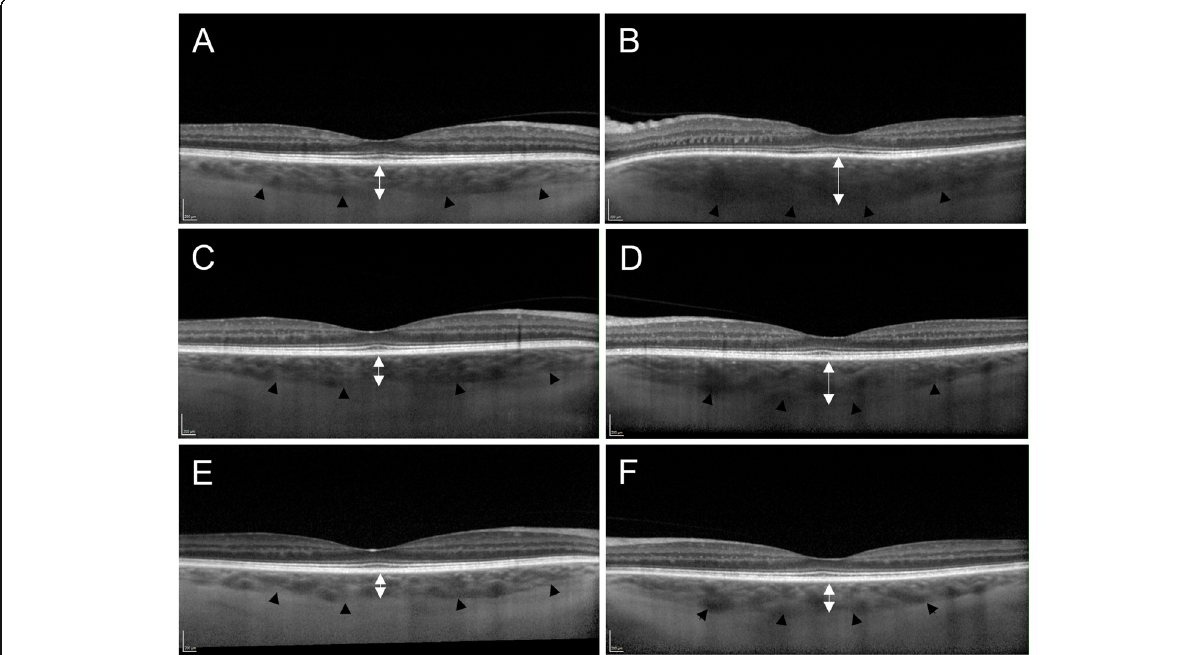
Fig. 1 Enhanced-depth imaging optical coherence tomography (EDI-OCT) in a case of left posterior scleritis. The black arrow heads delineate the choroidal- scleral junction. ( B ) Spectralis EDI-OCT demonstrates left subfoveal choroidal thickening on presentation (442 μ m). The B-scan ultrasound showed thickening of posterior coats (2.5mm) and fluid in Tenon's capsule and optic nerve sheath (not shown). ( D ) Subfoveal choroidal thickness in the left eye decreased 1 week (406 μ m) and ( F ) 4 weeks (292 μ m) after initiation of oral prednisolone. ( A , C , E ) Normal subfoveal choroidal thickness in the clinically unaffected right eye of the same patient at corresponding points in